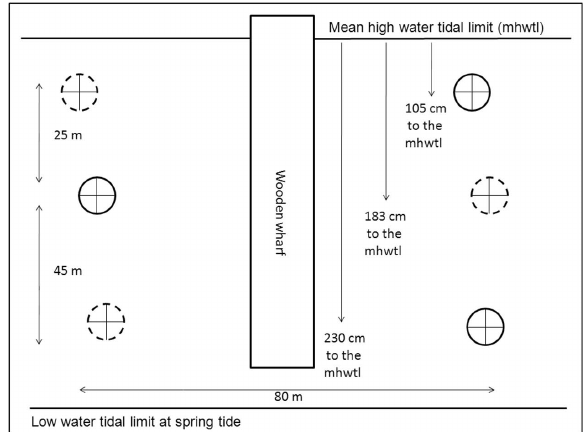
Fig . 2. – Schematic representation of the experimental design at the study site, Coina salt marsh. Excavated plots (open circles) and controls (solid-lined circles) are separated by a distance indicated by two-pointed arrows. The depth to the mean high water tidal level (mhwtd) of each experimental unit is indicated by a one-pointed